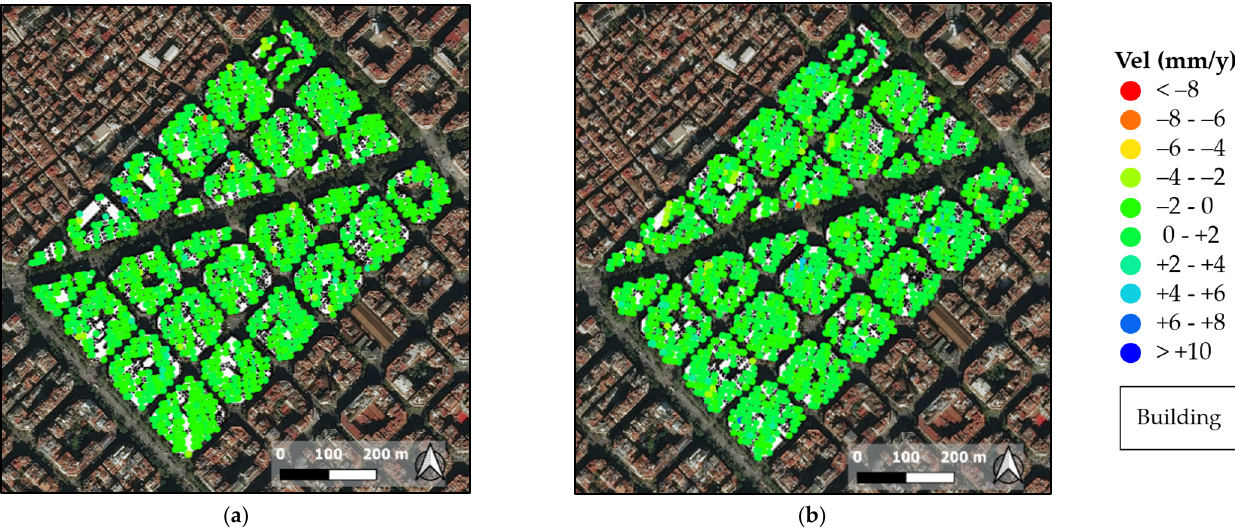
Figure 2. Distribution of the selected PSs on the buildings of the selected area of Eixample : ( a ) ascending and ( b ) descending.